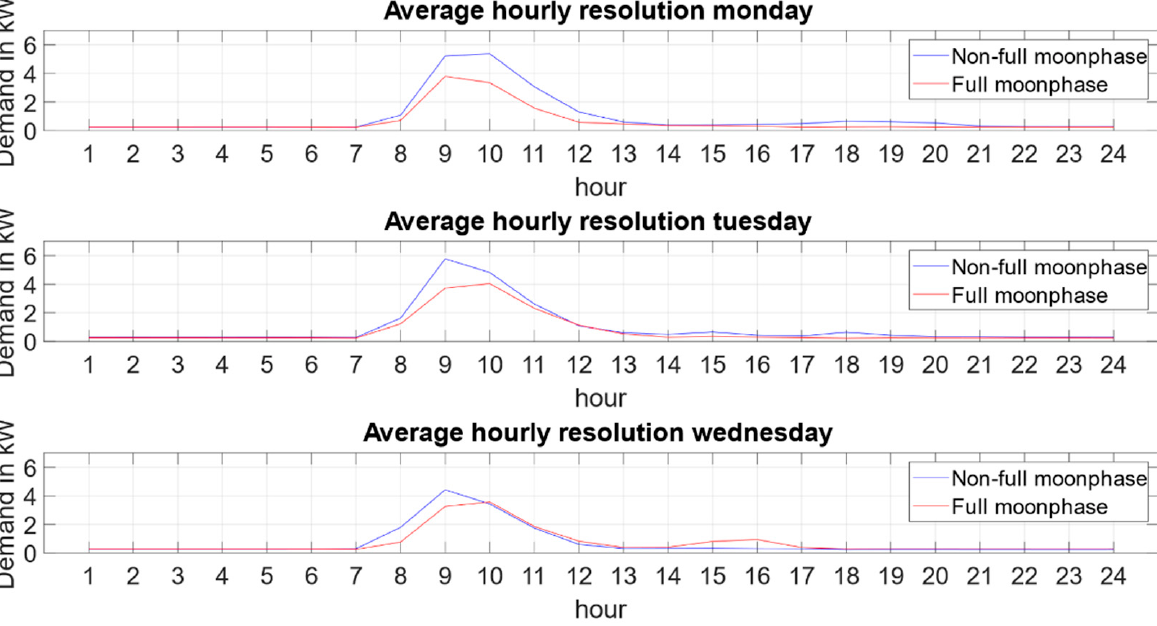
Figure 9 . Average hourly electricity demand profile from the measurement during moon phases.